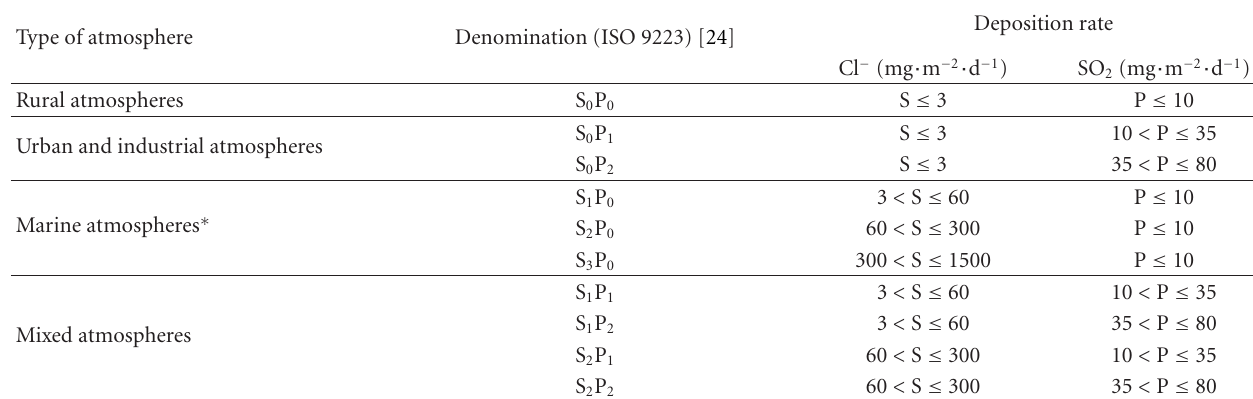
Table 3: Classification of MICAT test sites according to ISO 9223 [24].